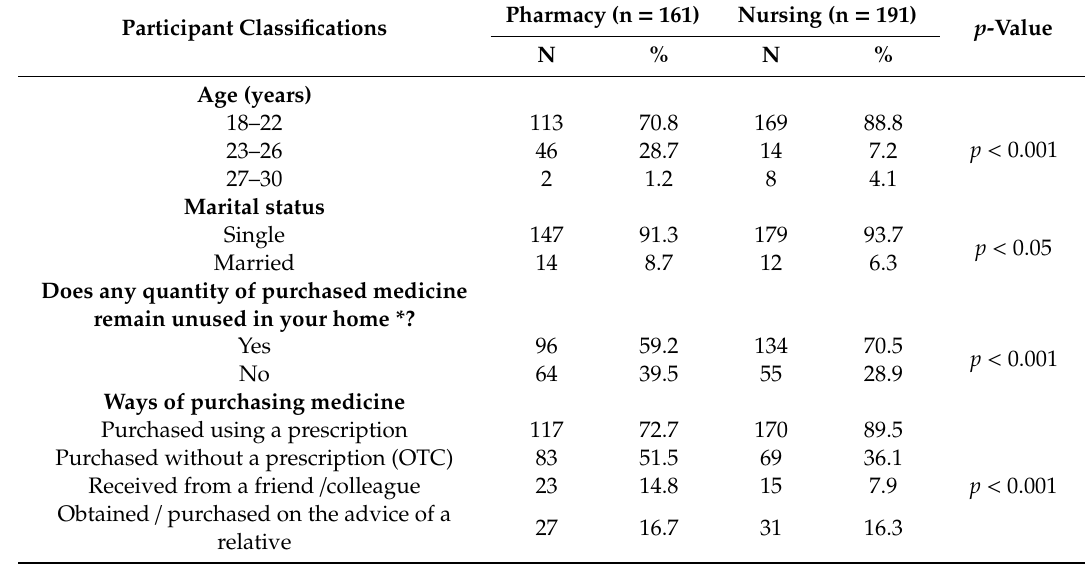
Table 1. Demographics, storage, and procurement of